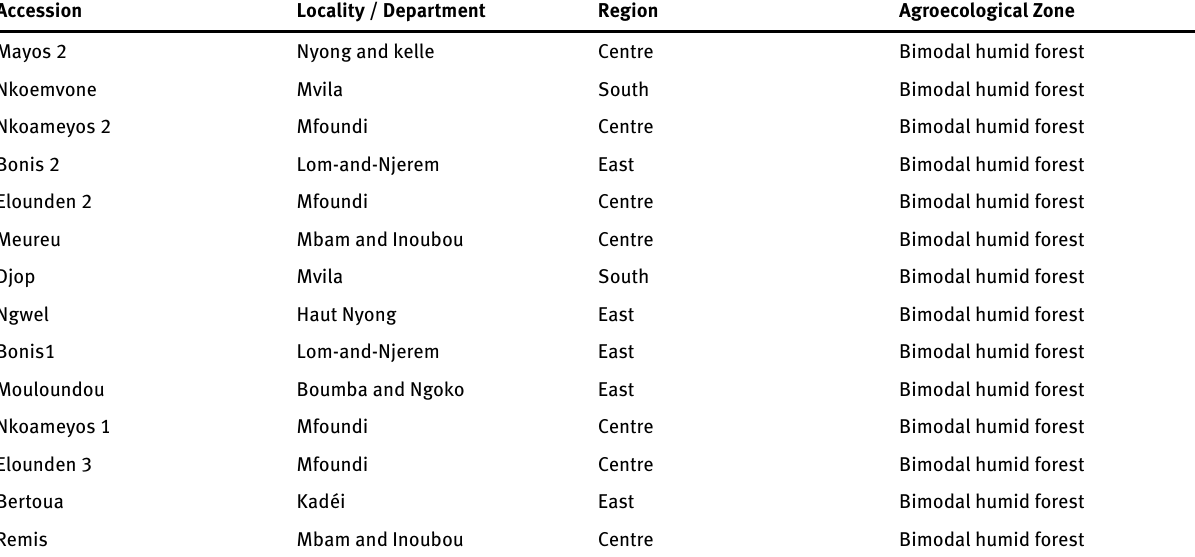
Table 1: List of accessions and their origin in